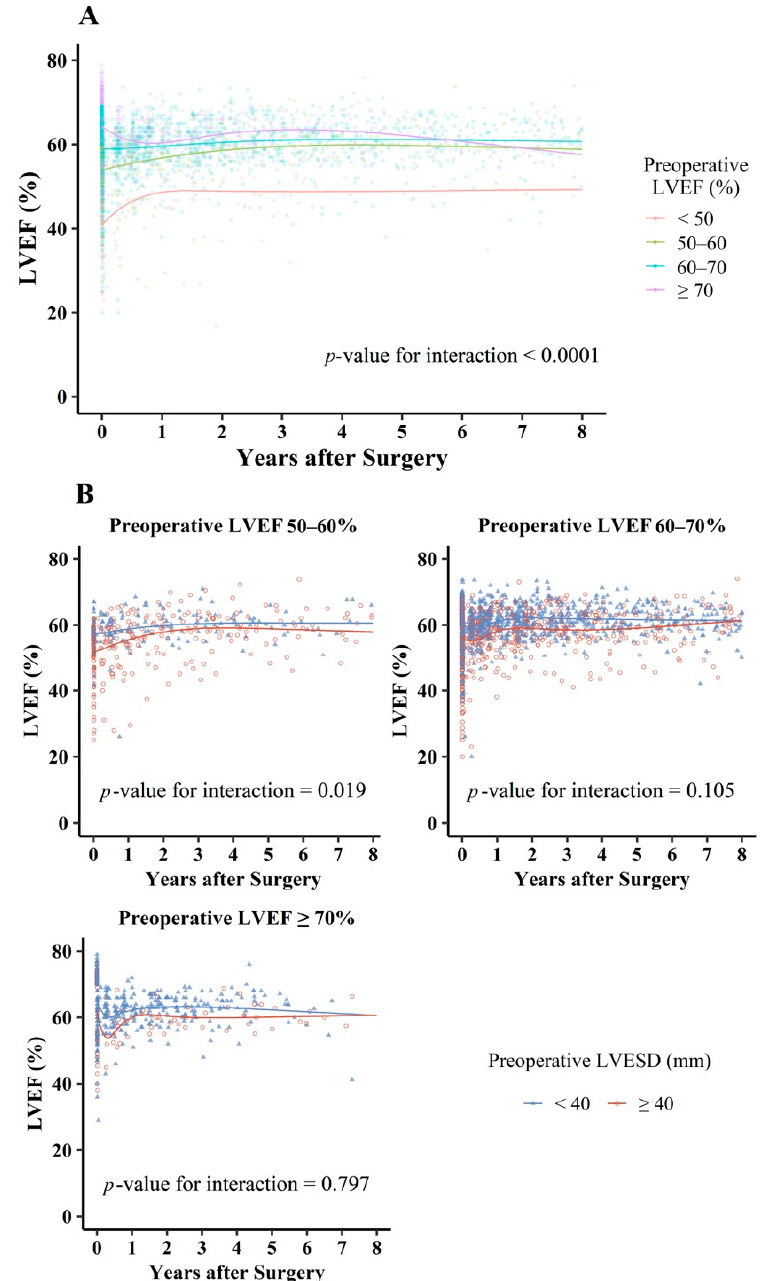
Figure 5. Restricted cubic spline curves of LVEF changes after mitral valve repair for chronic primary mitral regurgitation according to preoperative LVEF ( A ) and preoperative LVESD ( B ). LVEF: left ventricular ejection fraction; LVESD: left ventricular end-systolic diameter. A total of 33 patients died during the follow-up. Kaplan–Meier analysis showed a difference in mortality rate among the groups ( p = 0.0019), with the lowest mortality rate in Gr 60–70 (Figure 6). After adjustment for age, sex, and Charlson comorbidity index, the morality rate was lower in Gr 60–70 than in Gr 50–60 . The hazard ratio of mortality in Gr 50–60 was 3.82 (95% confidence interval, 1.77–8.27; p = 0.001), when Gr 60–70 was considered as a reference